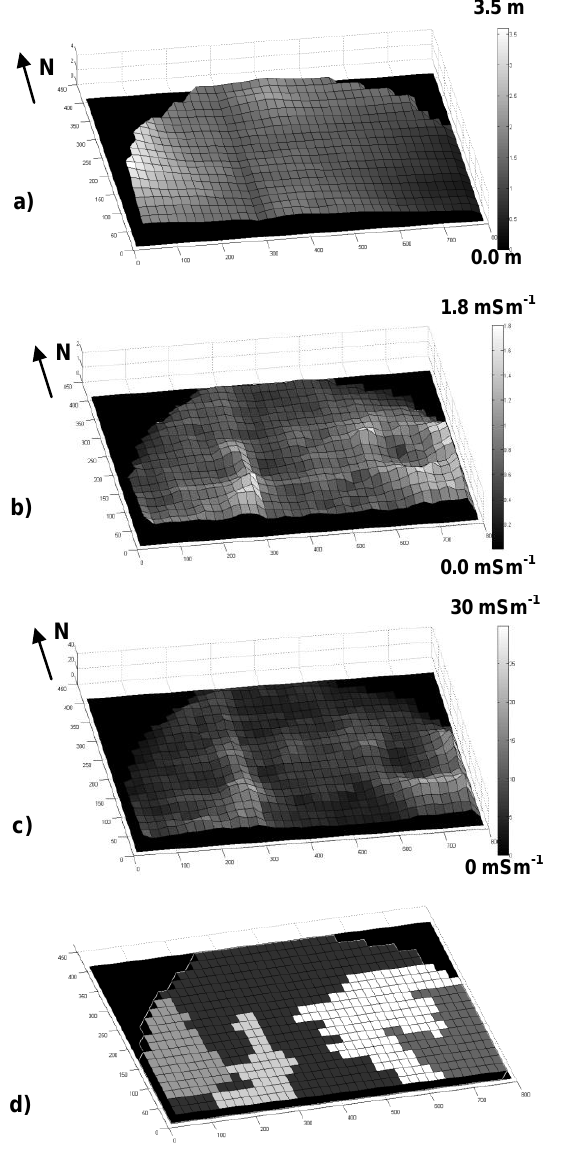
Figure 2. Maps of field elevation (a), shallow EC a (b), deep EC a (c), and delineated groups of grid cells (d) for Field 1.